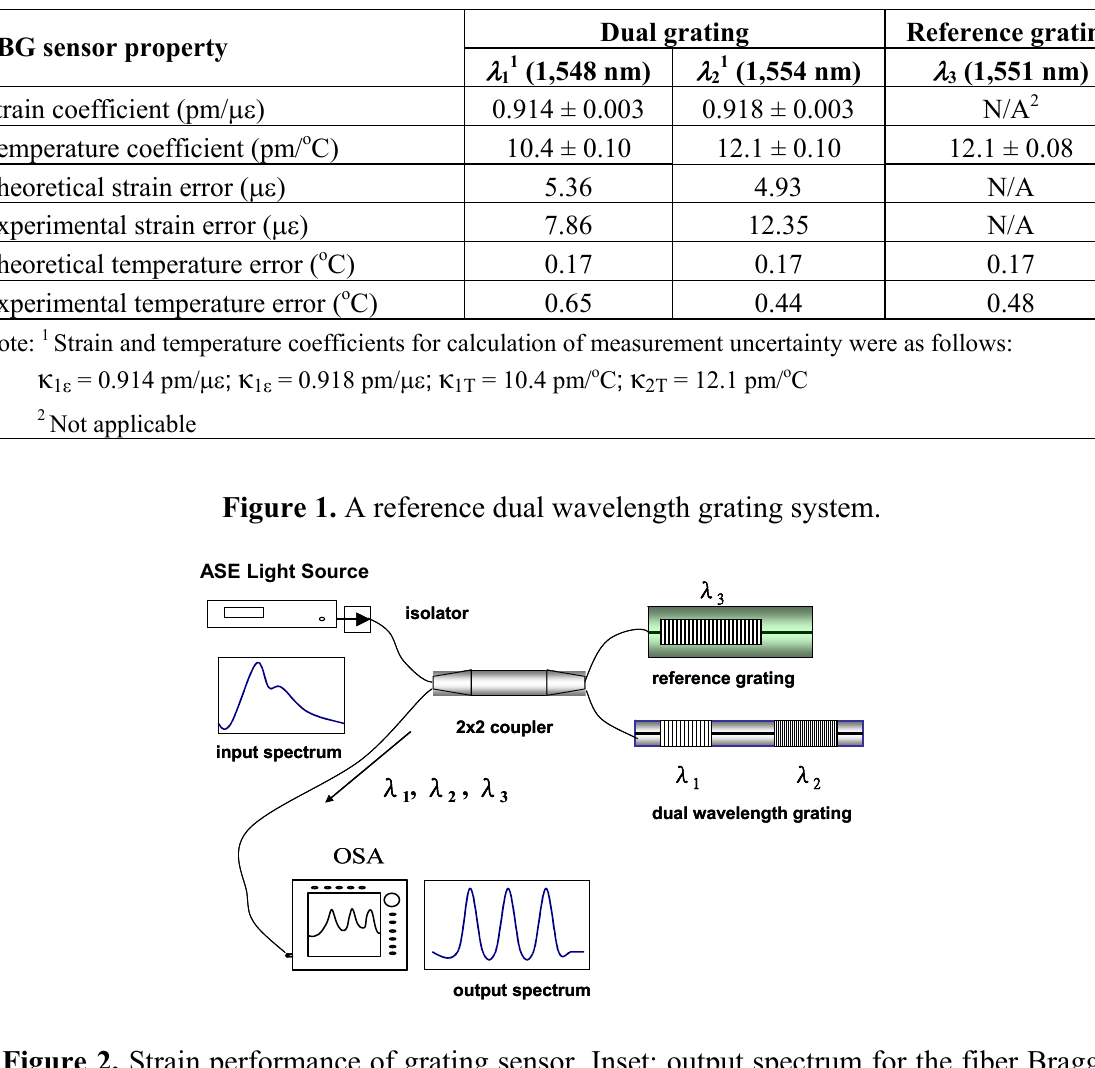
Table 1. Experimental and theoretical errors of individual strain and temperature measurement.